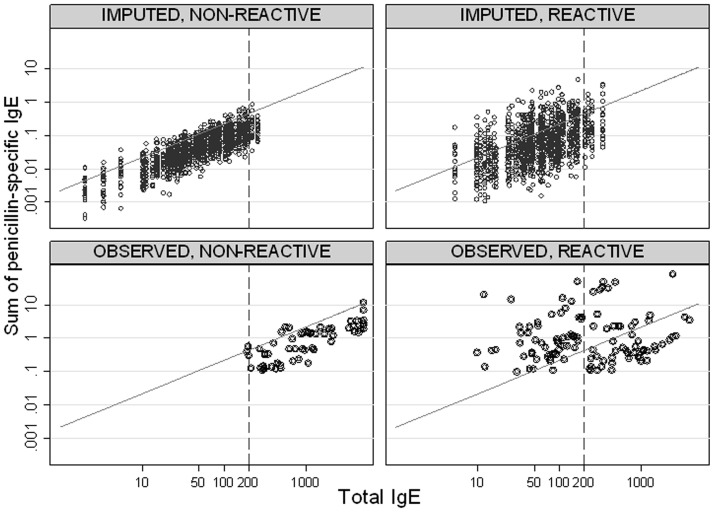
Scatterplot of the sum of β-lactam vs. total IgEs for observed and imputed values.Observed values (bottom row) and imputed values (upper row) as explained in the Methods. Observed and imputed data for non-reactive patients (left column) tend to line just below the ratio index threshold oblique line corresponding to 0.002 cut-off. See text for comments.